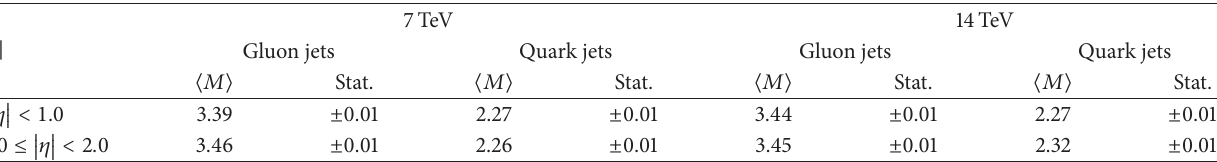
Table 1: Average subjet multiplicities for jets matched to gluons and quarks in the |𝜂| bins with 𝑃 jet 𝑇 > 100 GeV for 𝑘 𝑇 algorithm at √𝑠 = 7TeV and √𝑠 = 14TeV.